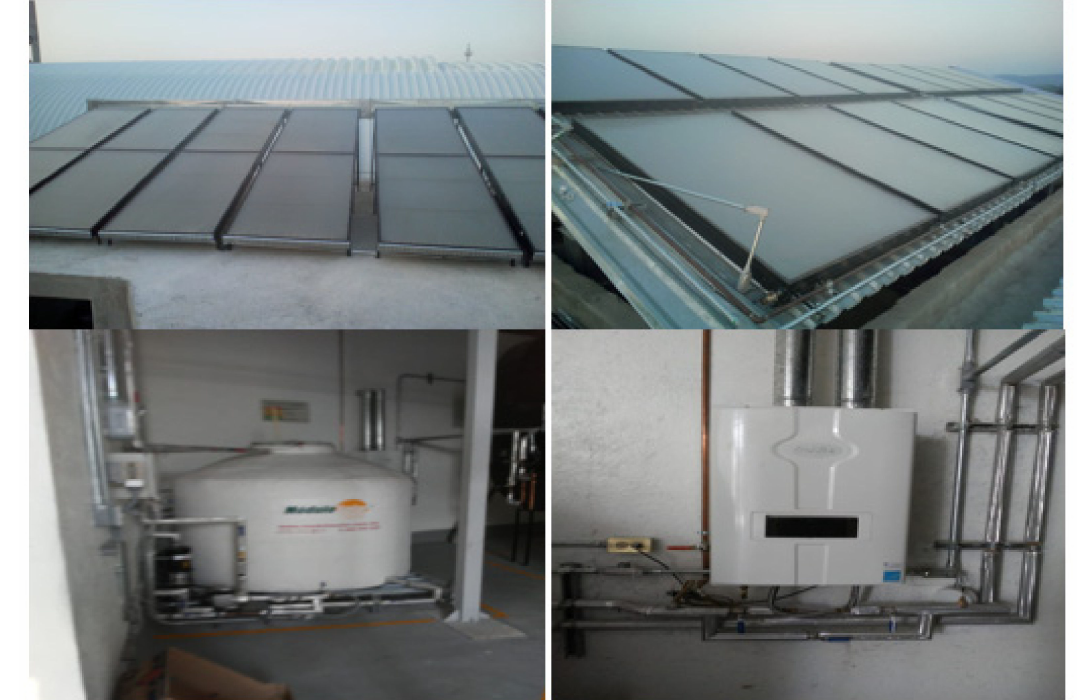
Figure 2. Components of the solar air heating system.